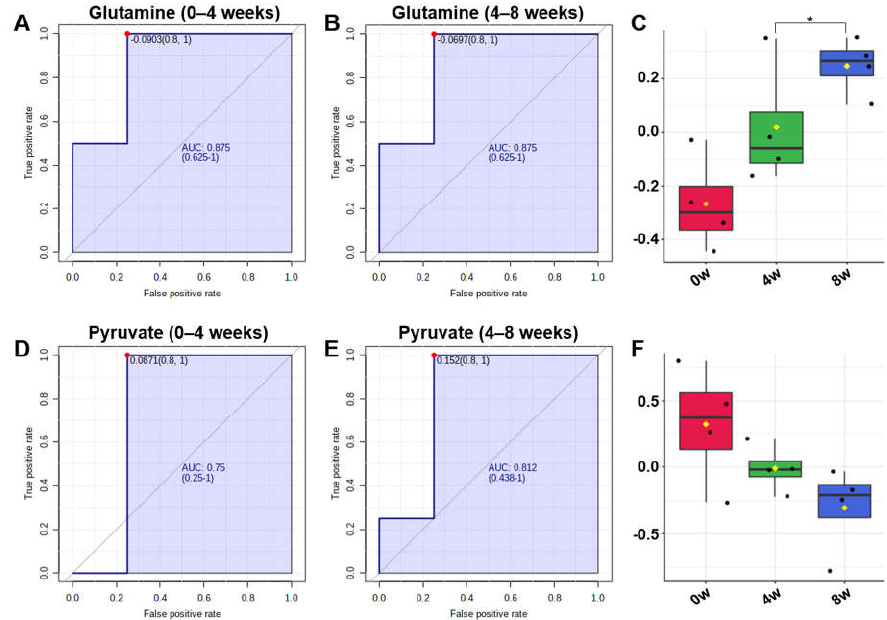
Figure 6. Biomarker analysis of 0 and 4 weeks and 4 and 8 weeks after feeding of black ginseng. ( A ) Receiver operating characteristic (ROC) curves of glutamine comparing 0 and 4 weeks and ( B ) 4 and 8 weeks. ( C ) Box plot of glutamine concentrations (* p -value < 0.05). ( D ) ROC curves of pyruvate comparing 0 and 4 weeks and ( E ) 4 and 8 weeks. ( F ) Box plot of pyruvate